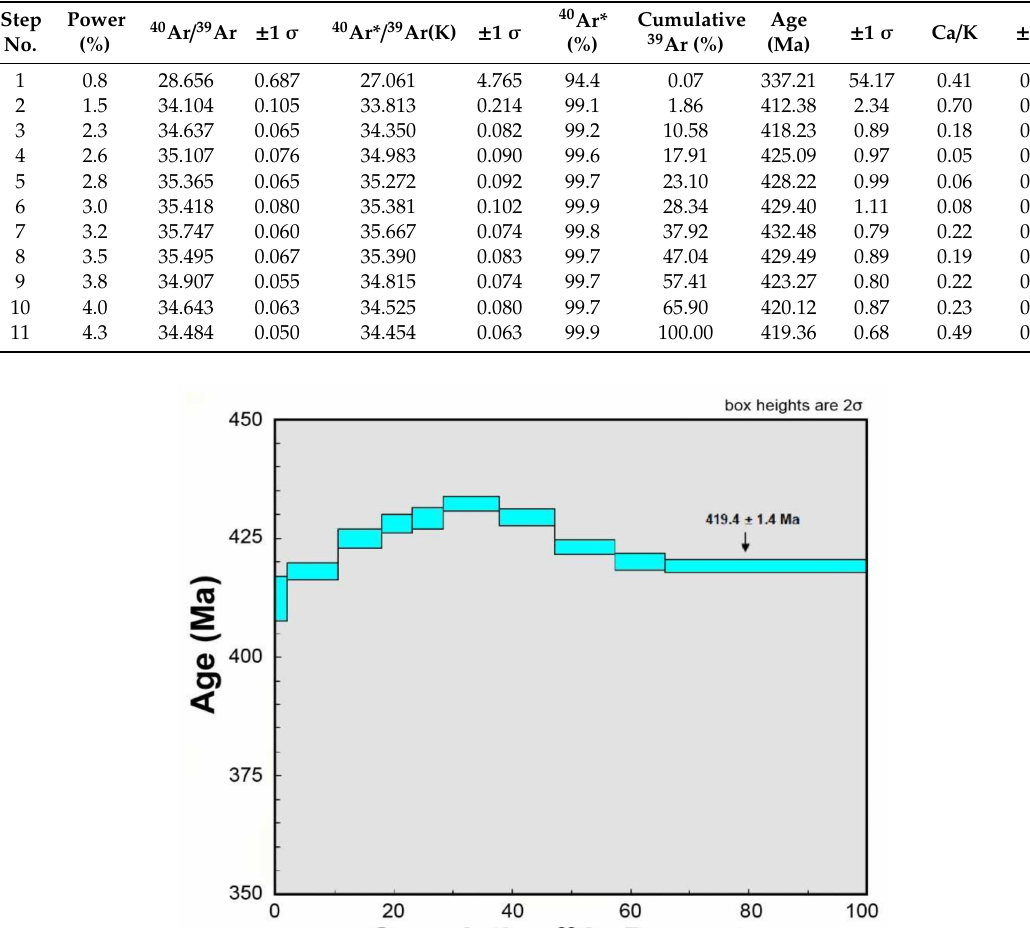
Table 6. Argon step heating data of phlogopite separate from sample 80-12, J value = 0.007576 ±